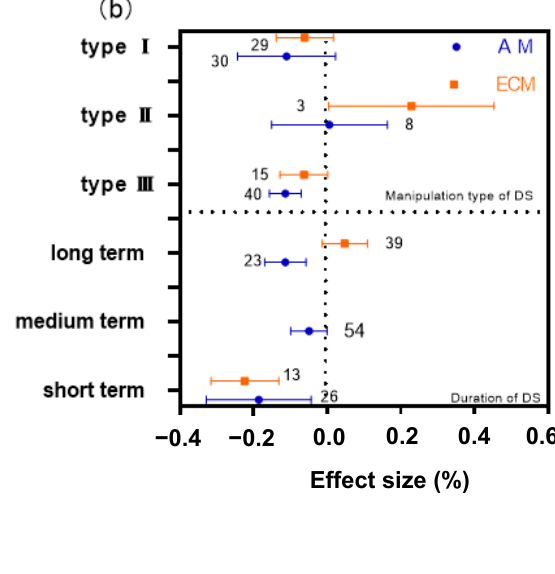
Figure 1. The error bar represents a 95% bootstrap confidence interval (CIs). If log e R 95% CI did not overlap with zero, the effect of drought stress was considered significant. Here “*” means significant difference, and “***” means very significant difference.